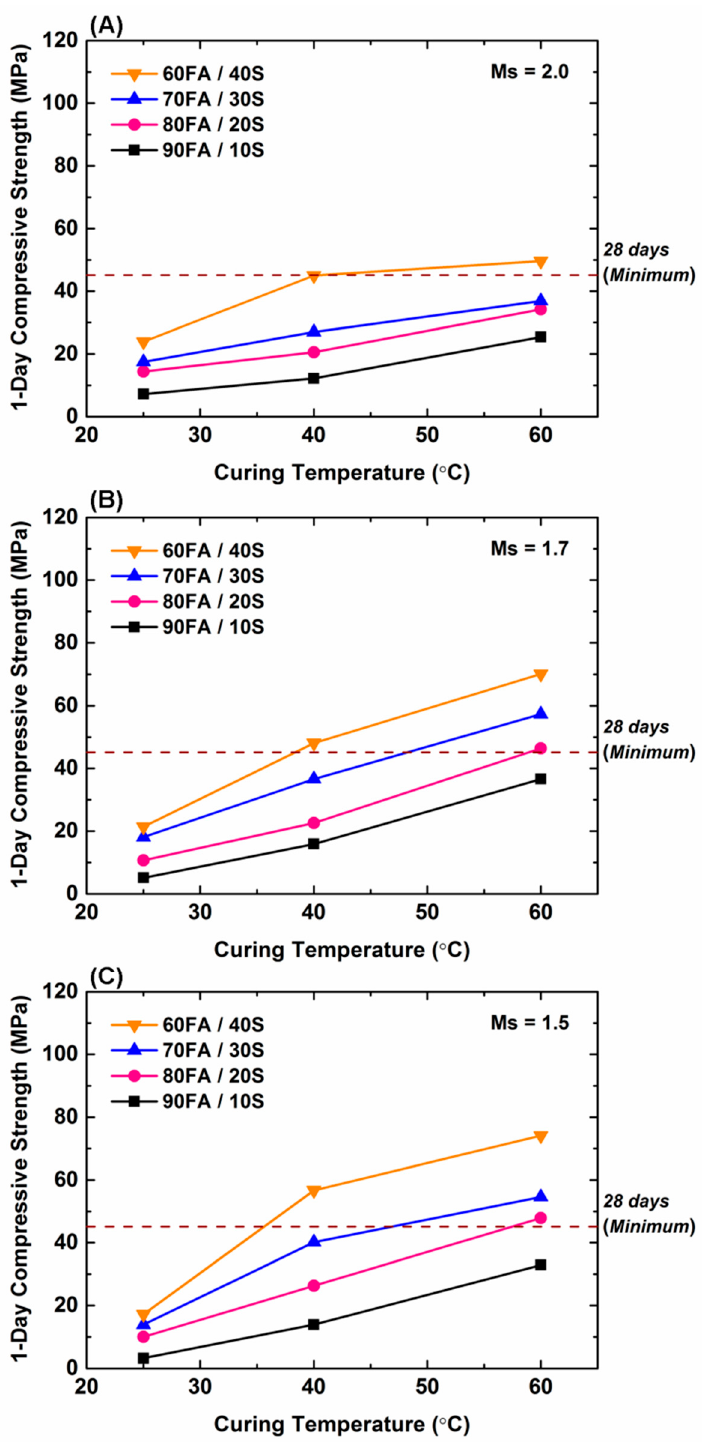
Figure 4. ( A – C ) 1-day compressive strength as a function of curing temperature, Ms value, and slag content.